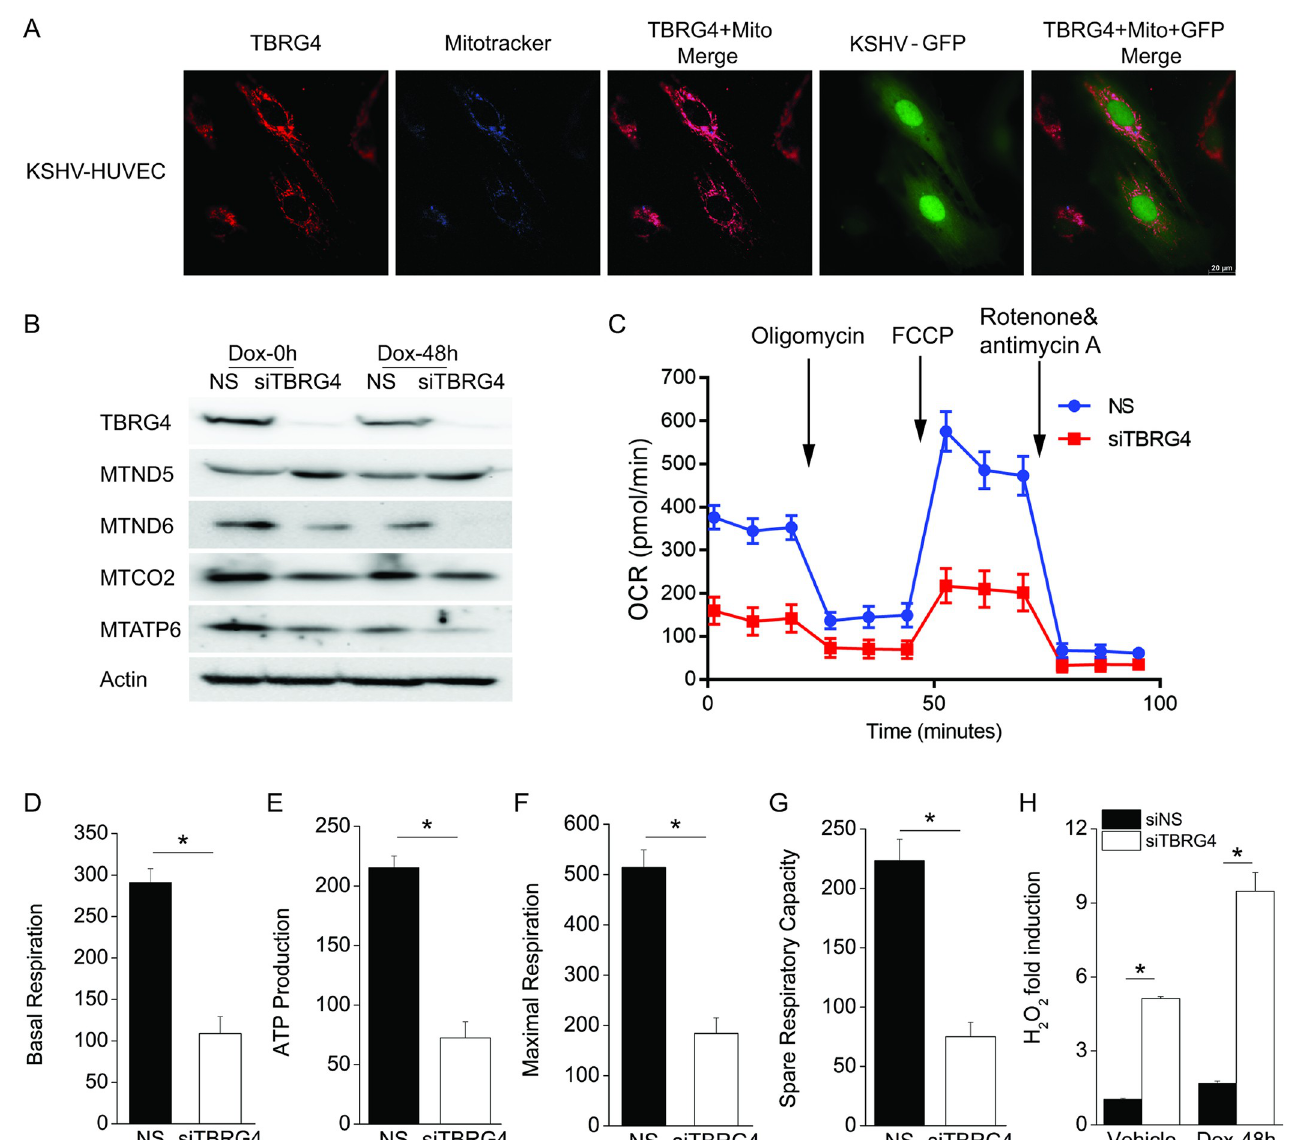
Fig 4. Depletion of TBRG4 causes mitochondrial stress and increases ROS. (A) KSHV-HUVEC were treated with MitoTracker to visualize the mitochondria (blue), then fixed and stained with TBRG4 antibody (red). KSHV-HUVEC cells contain a recombinant KSHV constitutively expressing GFP (green). Images were collected using a Leica DMi8. (B) iSLK.219 cells were transfected with NS and TBRG4 siRNA for 48 hours and then treated with 0.2 μ g/ml Dox for 0 and 48 h. Cells lysates were collected and western blots were performed with the indicated antibodies. (C-G) iSLK.219 cells were transfected with NS and TBRG4 siRNA for 96 h, then mitochondrial respiration was evaluated in living cells using a Seahorse XF analyzer. Oxygen consumption ratio (OCR) was measured during sequential treatment with oligomycin (1.5 μ M), FCCP (0.5 μ M) and rotenone/antimycin A (1 μ M). Quantification of the basal oxygen consumption, ATP production, maximal respiration, and spare respiratory capacity are shown in the indicated panels. (H) iSLK.219 cells were transfected with NS and TBRG4 siRNA for 48 h, then treated with 0.2 μ g/ml Dox for 0 and 48 h. The level of H 2 O 2 was measure with ROS-Glo H 2 O 2 assay. H 2 O 2 substrate was added for 5 h and luminescence signal was measured and is presented as fold